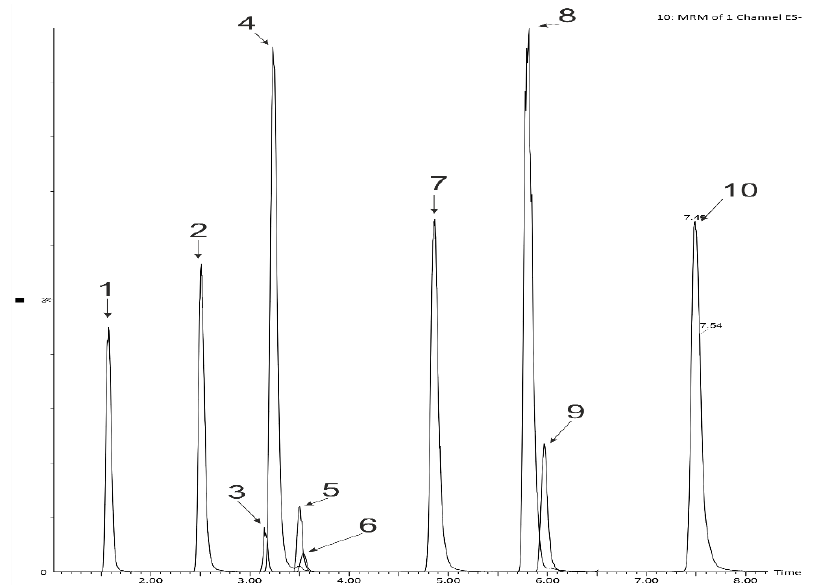
Figure 2. LC-MS-MRM chromatogram of phenolic acids standards: 1 — protocatechuic, 2 — 4-OH-benzoic, 3 — vanillic, 4 — caffeic, 5 — 3-OH -benzoic (internal standard), 6 — syringic, 7 — p -coumaric, 8 — ferulic, 9 — sinapic, 10 — salicylic.